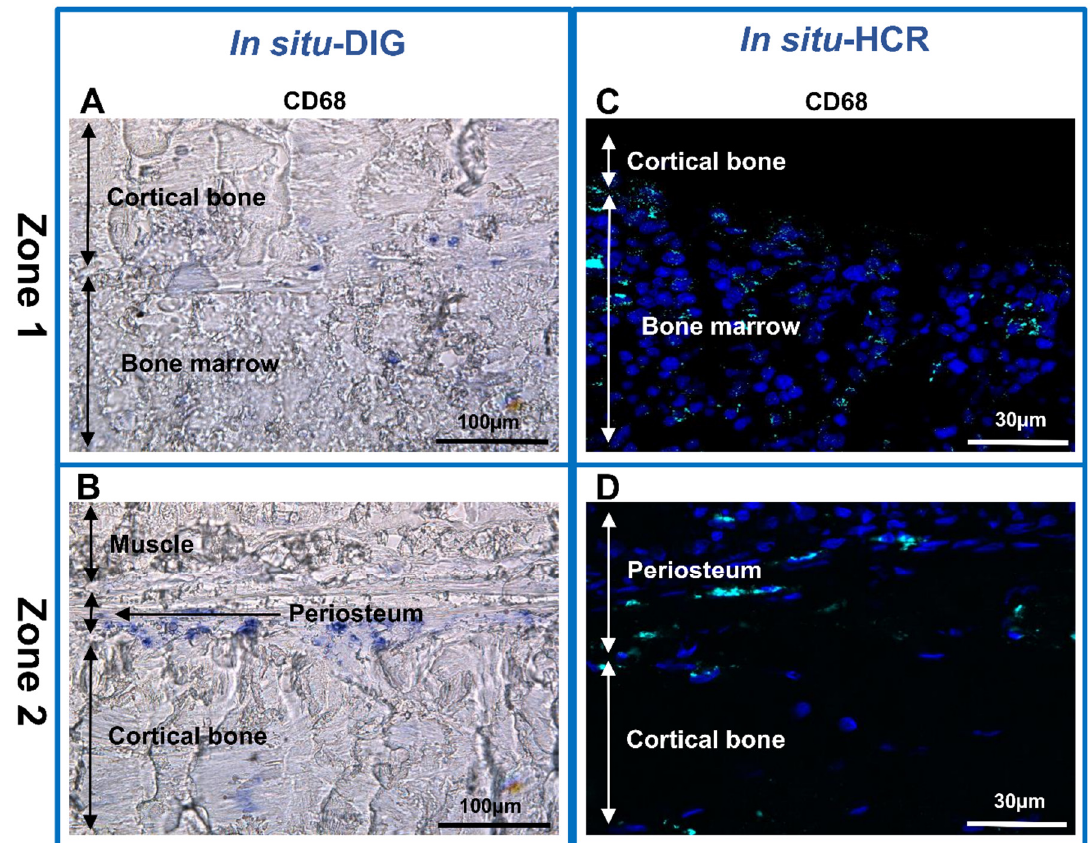
Figure 5. In situ hybridization analysis in non-decalcified rat bone section. ( A – D ) CD68 mRNA expression in section of two representative zones of the sample. ( A , C ) Zone 1-cortical bone and bone marrow. ( B , D ) Zone 2-muscle, periosteum and cortical bone. ( A , B ) In situ-DIG; ( C , D ) in situ-HCR.